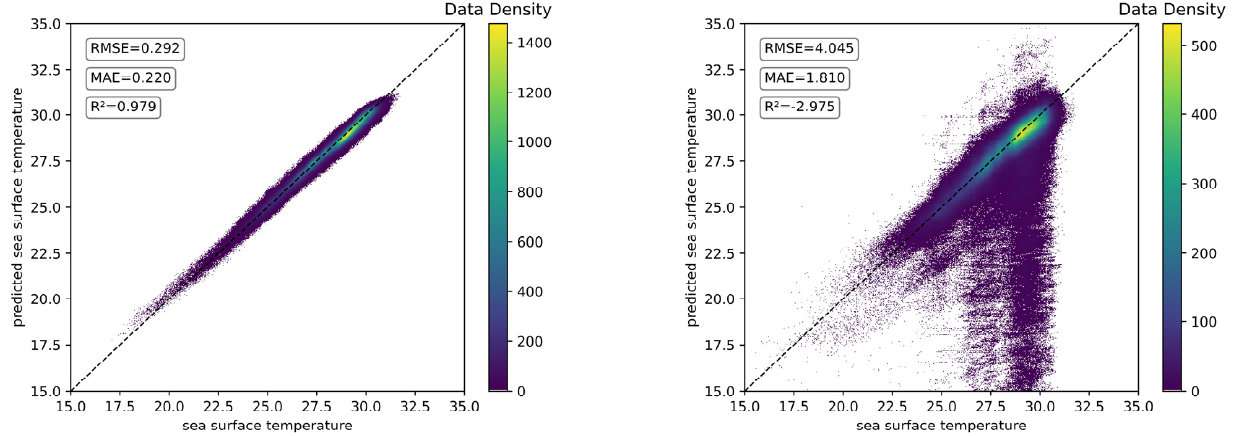
Figure 10. Comparison of SST prediction performance using ConvLSTM. On the left, the hidden size is set to 64, and on the right, it is set to 2.